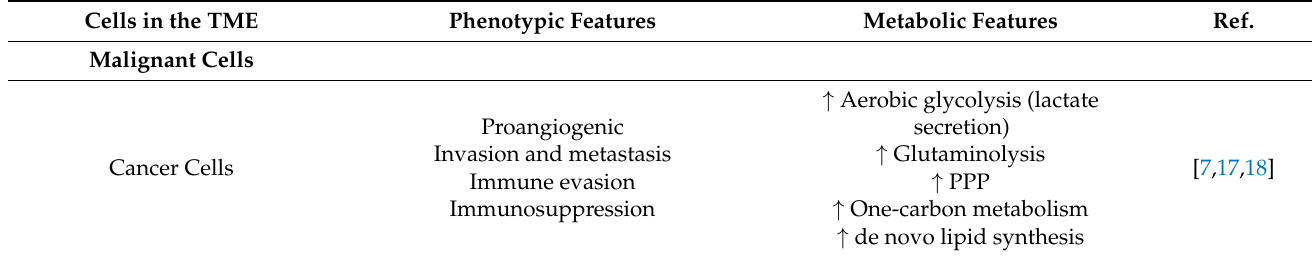
Table 1. Main phenotypic and metabolic features of cells in the tumor microenvironment. Cells in the TME Phenotypic Features Metabolic Features